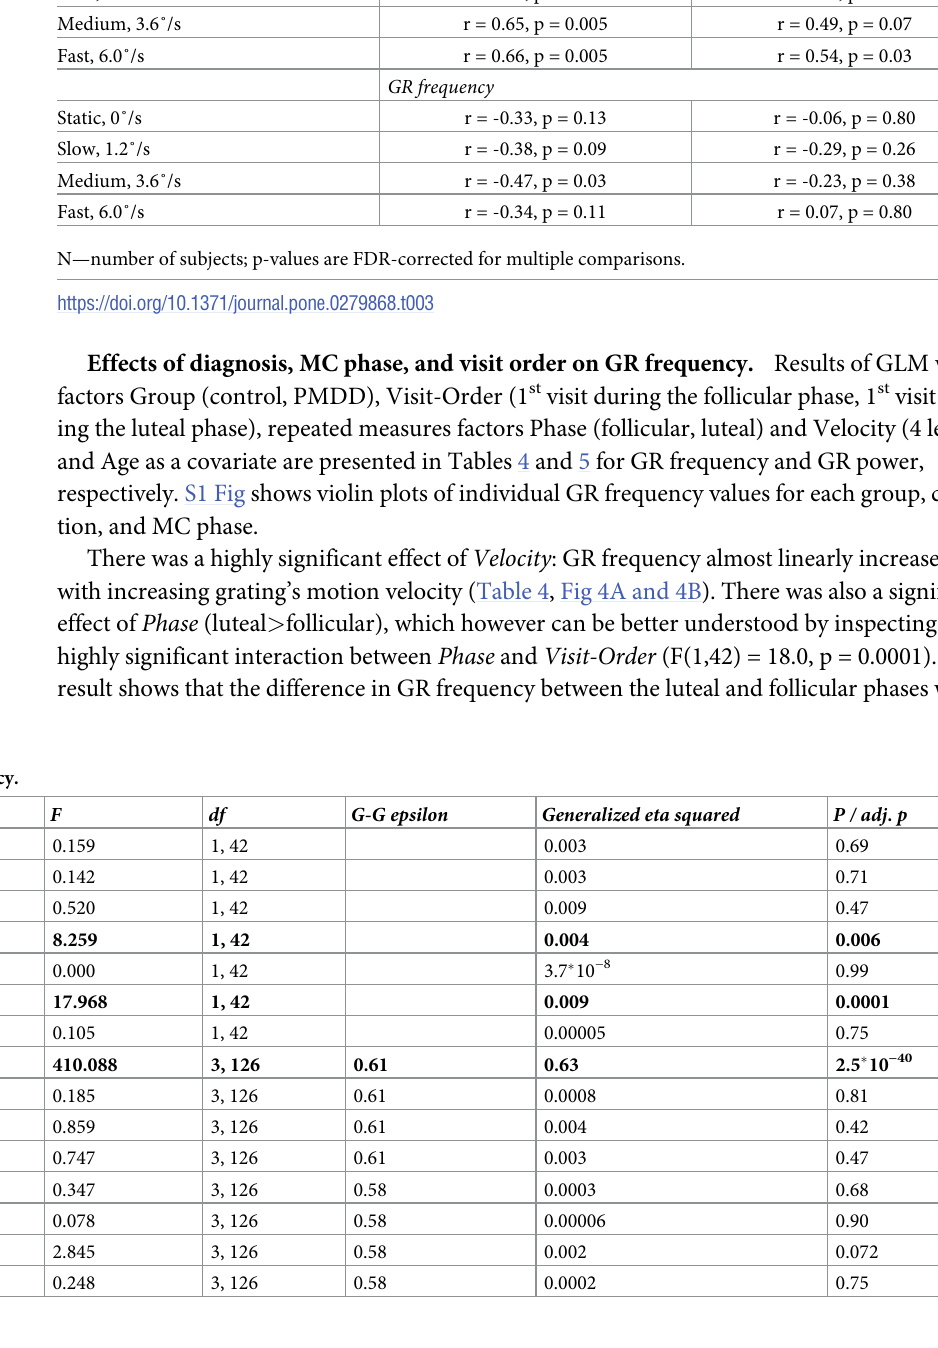
Table 3. Pearson’s correlations between age and gamma response (GR) power (log10-transformed) and frequency in the two groups of participants (control and PMDD). Gamma parameters were averaged over the two phases of the menstrual cycle.